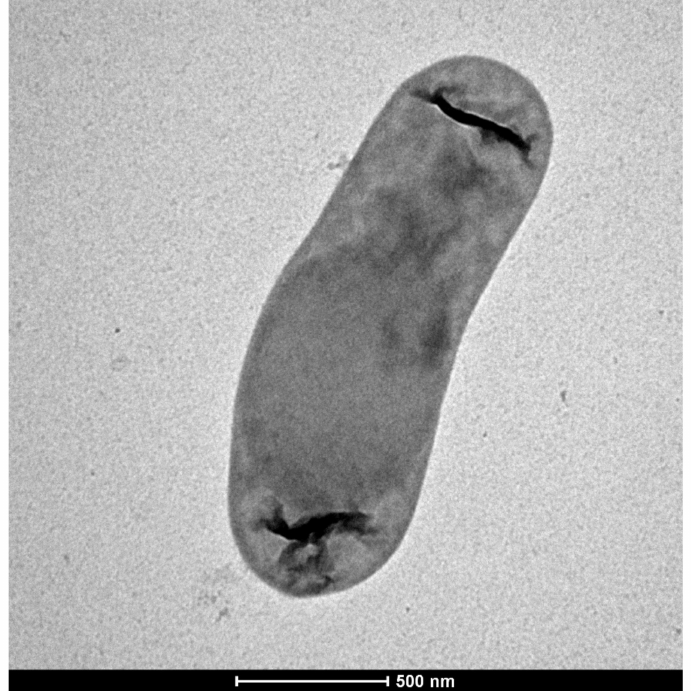
Figure 1. Electron micrograph of a representative KRL4 cell cultured in LB medium. Dark sub- terminal features may be an artifact of the TEM imaging, however these have been noted in other Exiguobacterium isolates but have to date not been